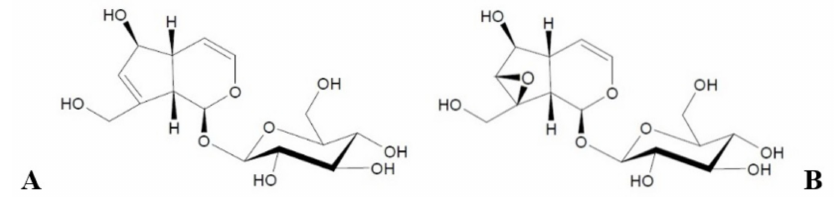
Figure 1. Structural formulas of aucubin ( A ) and catalpol ( B